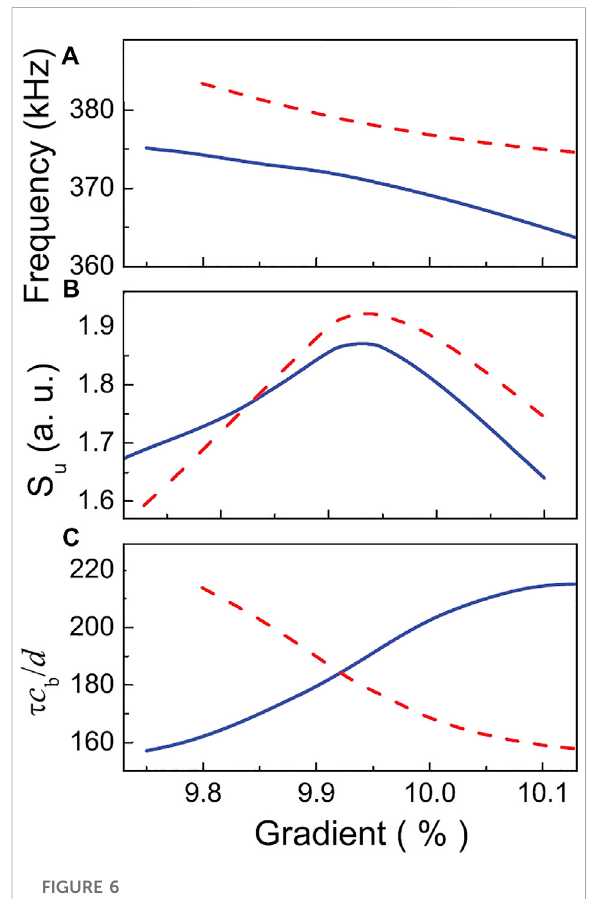
FIGURE 6 (A) The frequency of the two interacting modes near the avoided crossing region for the system experimentally characterized in [34]. (B) The Shannon entropy, S u , in arbitrary units. (C) The lifetime, τ , (in reduced units) of modes involved in the interacting process. The blue continuous (red dashed) lines represent magnitudes associated to mode u 1 ( u 2